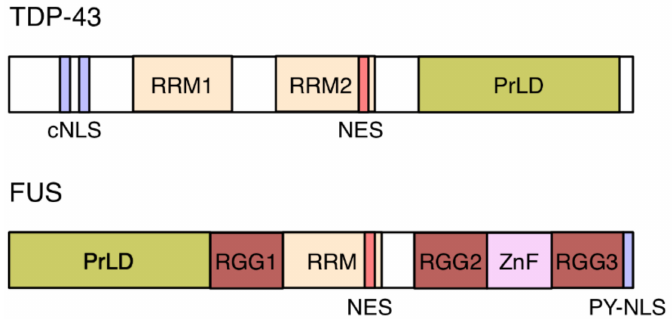
Figure 3. Domain structure of TDP-43 and FUS. TDP-43 contains two RNA recognition motifs (RRM), two predicted adjacent nuclear export signals (NESs), and a classical bipartite nuclear localization signal (cNLS). Its C-terminal domain harbors a low-complexity, prion-like domain (PrLD). The PrDL of FUS is located in its N-terminal half. FUS further contains two predicted adjacent NESs, one RRM, one zinc-finger (ZnF), and three arginine-glycine-glycine (RGG) repeat domains that stabilize